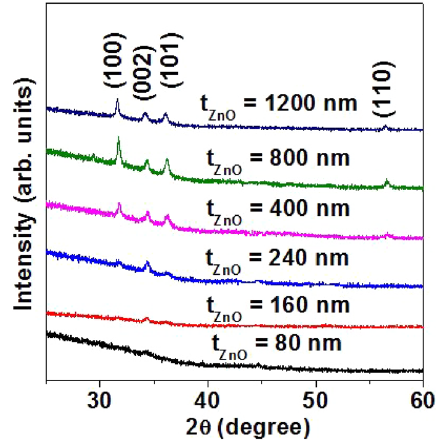
Fig. 1 XRD pattern of ZnO thin films deposited at differ- ent t